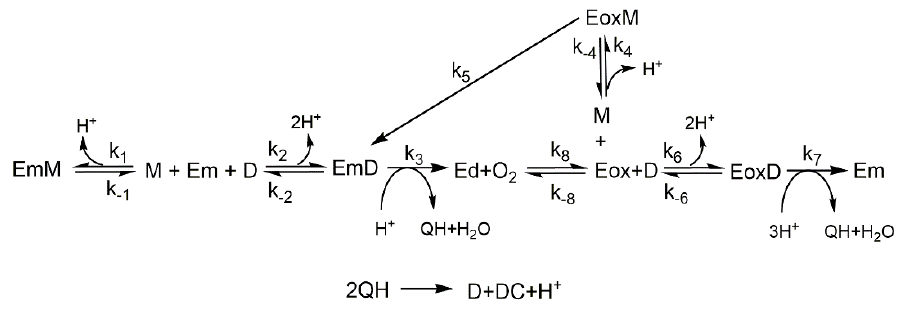
Scheme 1. Monophenolase and diphenolase activities of tyrosinase. M is monophenol, D is o ‐ diphenol, QH is o ‐ dopaquinone protonated and DC is dopahrome. The enzymatic forms are: Em